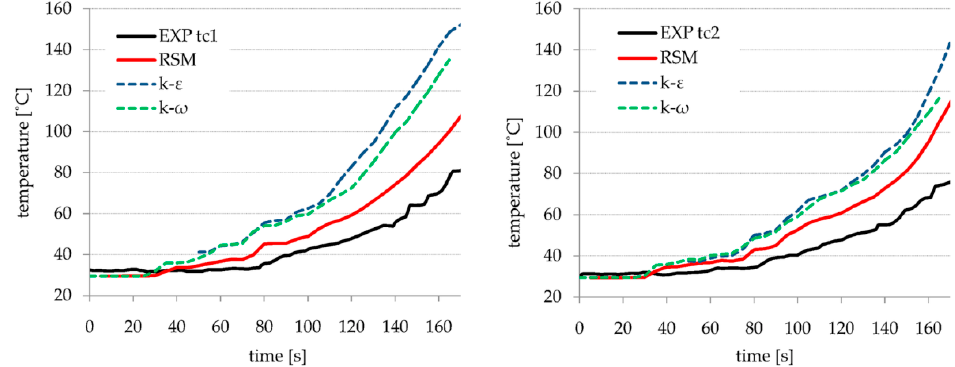
Figure 5. Time dependence of calculated and measured temperature for different turbulence models for experiment #10.